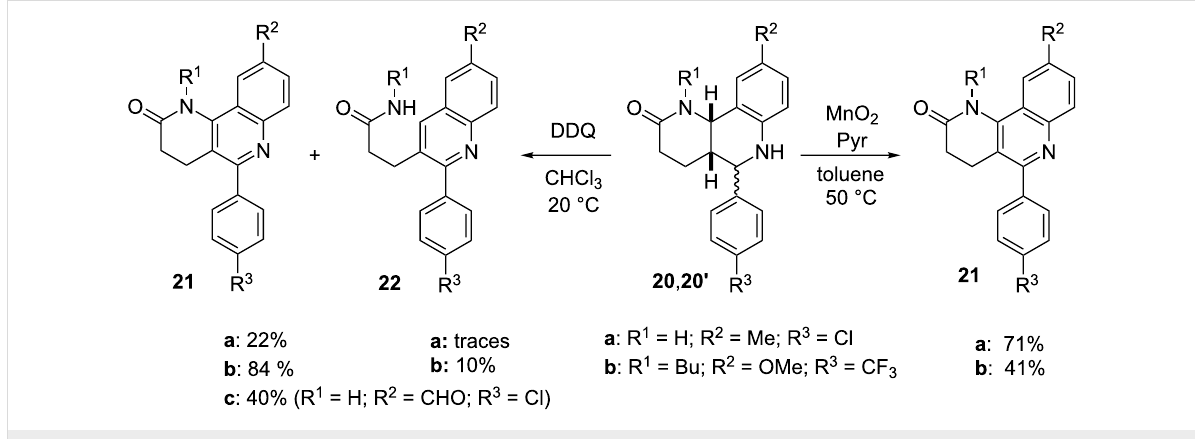
Scheme 4: Oxidation of lactam-fused tetrahydroquinolines 20 , 20'